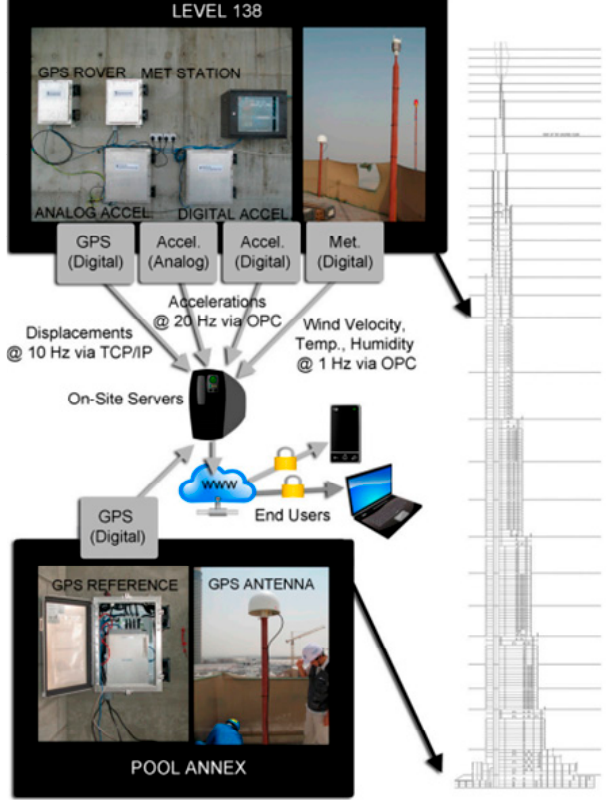
Figure 7. Single-layer deployment of SmartSync in Burj Khalifa Tower during construction.